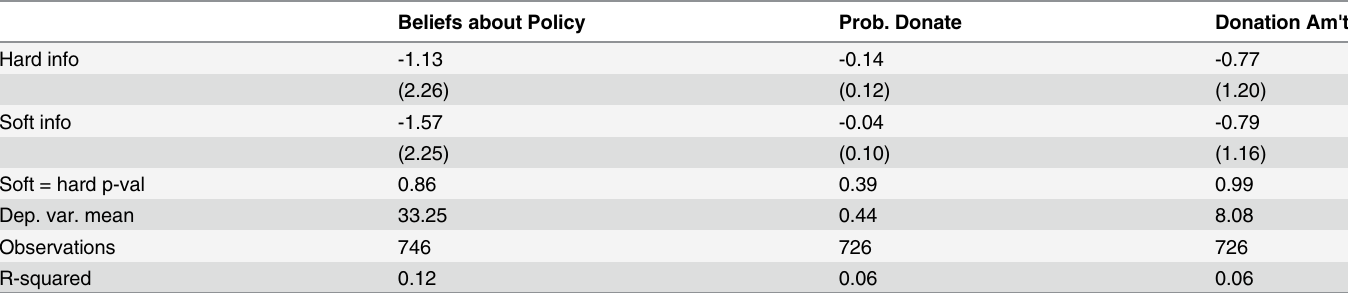
Table 7. Average long-run effects of information on policy actions. Beliefs about